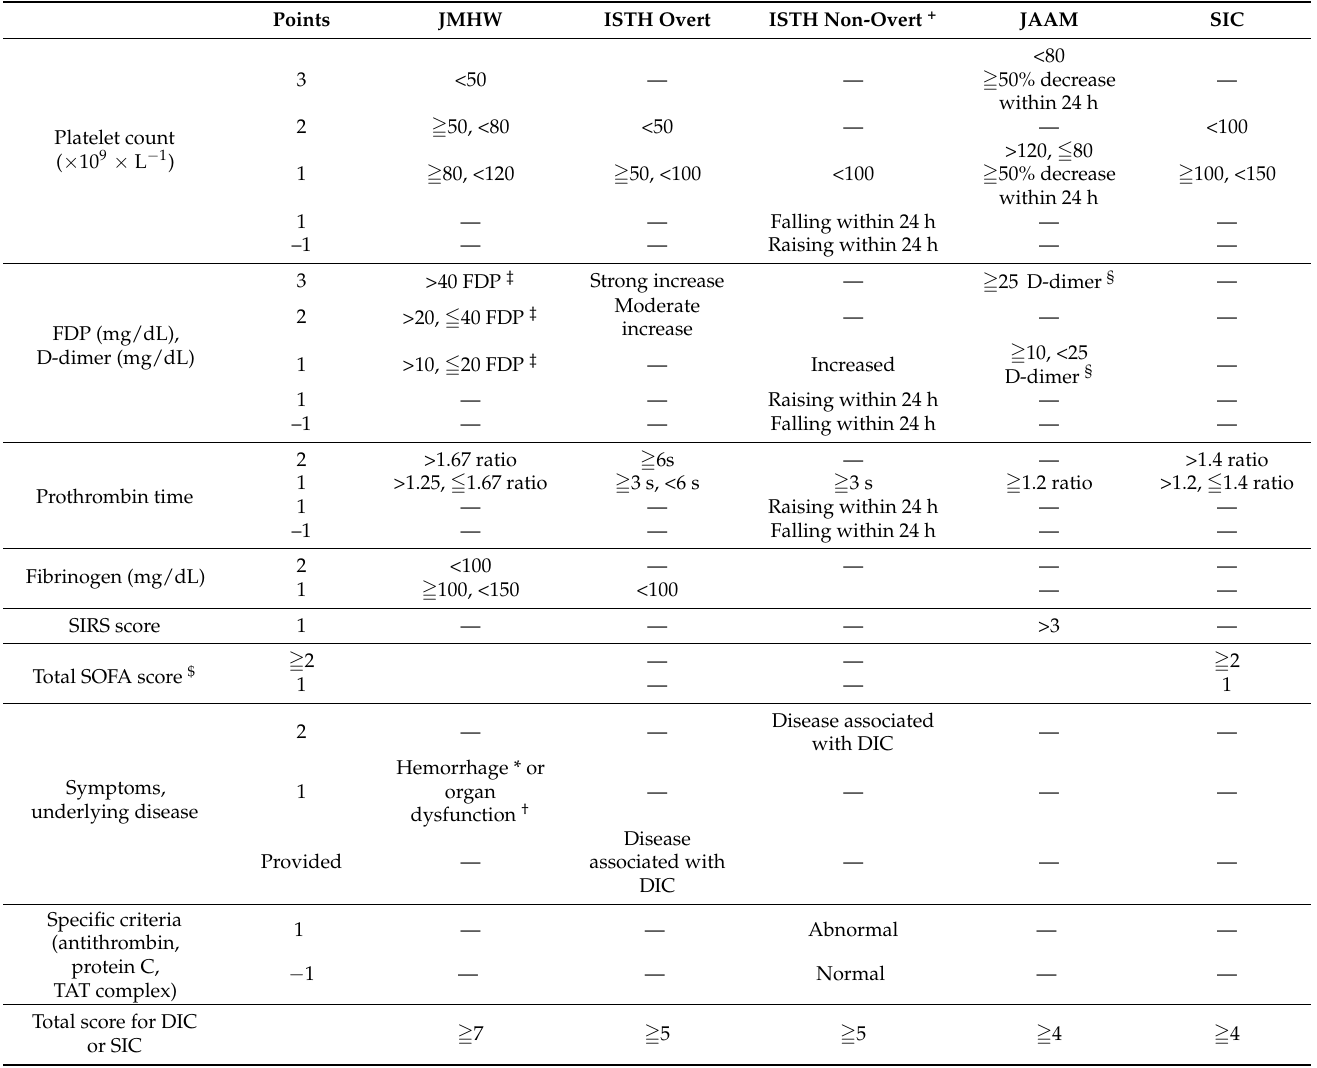
Table 1. Japanese Ministry of Health and Welfare DIC, International Society on Thrombosis and Haemostasis Overt DIC and Non-Overt DIC, Japanese Association of Acute Medicine DIC, and Sepsis-Induced Coagulopathy Scoring